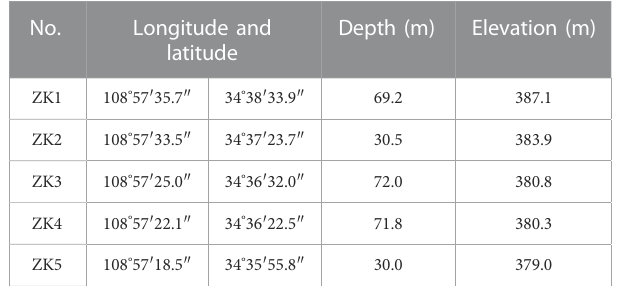
TABLE 2 The locations and depths of the